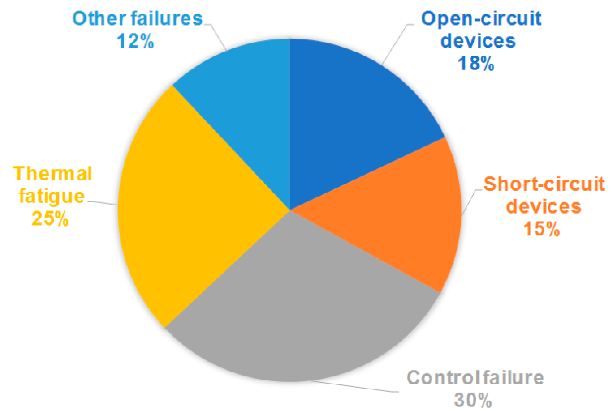
Figure 1. Pie diagram of failure distribution in power semiconductor devices.